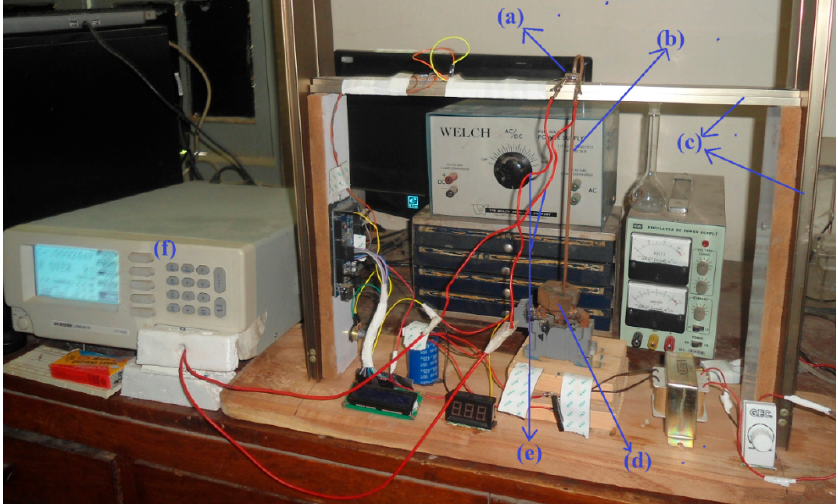
Figure 3. Experimental setup: ( a ) fabricated sensor, ( b ) weight holder, ( c ) metallic support, ( d ) weight, ( e ) test lips of the LCR meter connected with the terminals of the fabricated sensor, ( f ) GW Instek 817 LCR Meter.